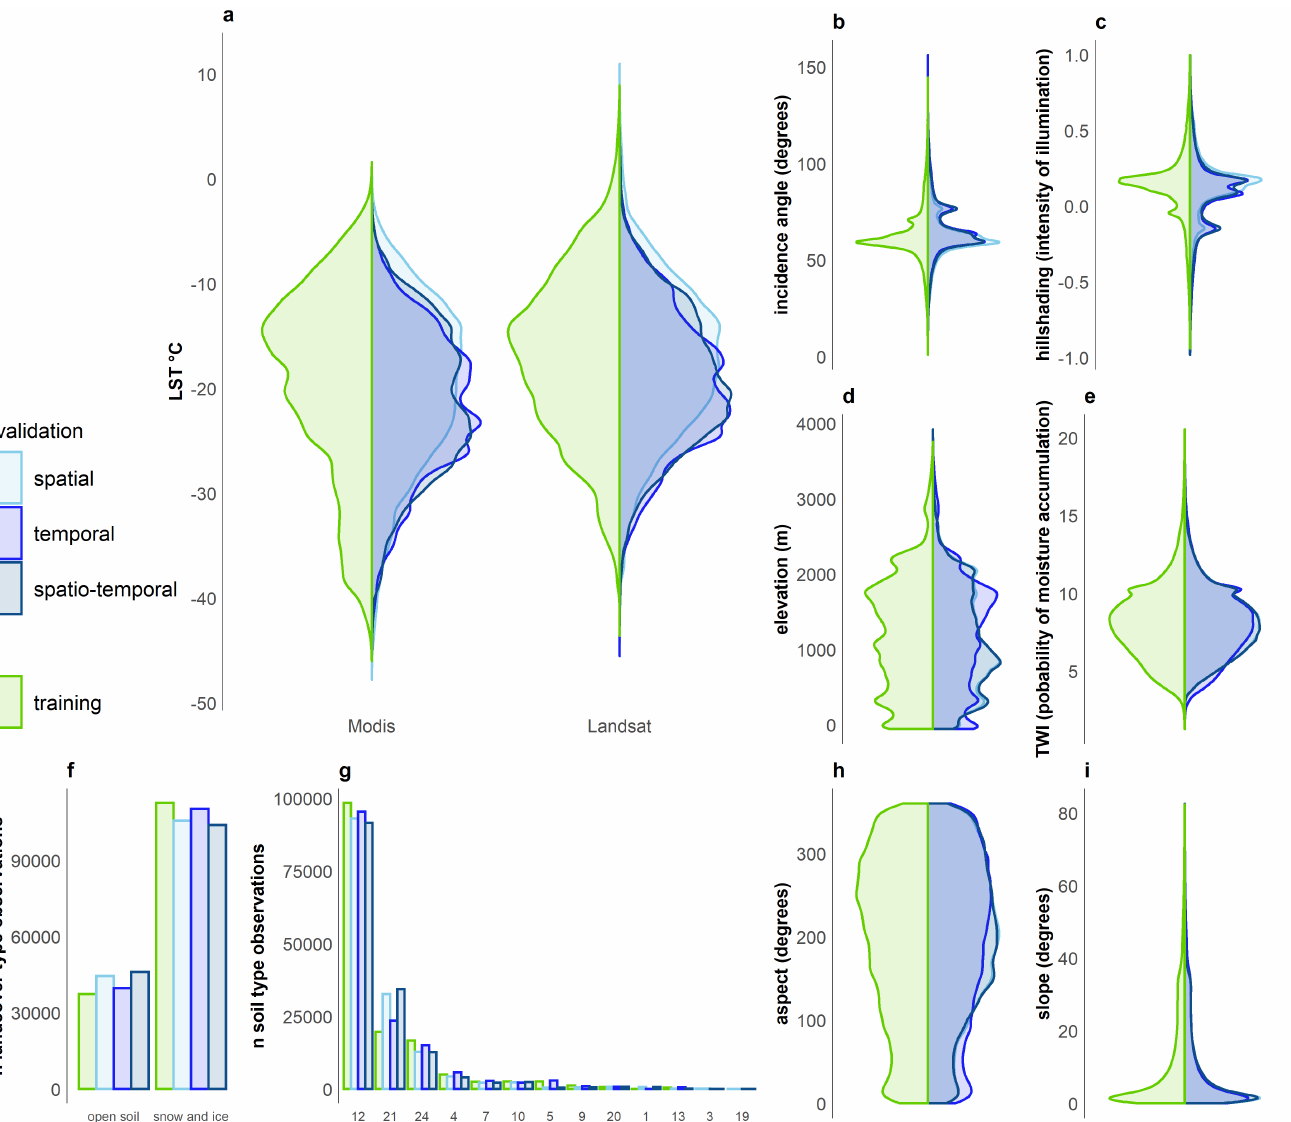
Figure 4. Variable distribution of training and validation data sets for ( a ) to be downscaled MODIS and response variable Landsat LST and predictor variables ( b ) incidence angle, ( c ) hillshading, ( d ) elevation, ( e ) TWI, ( f ) landcover type, ( g ) soil type as documented in [54], ( h ) aspect and ( i )